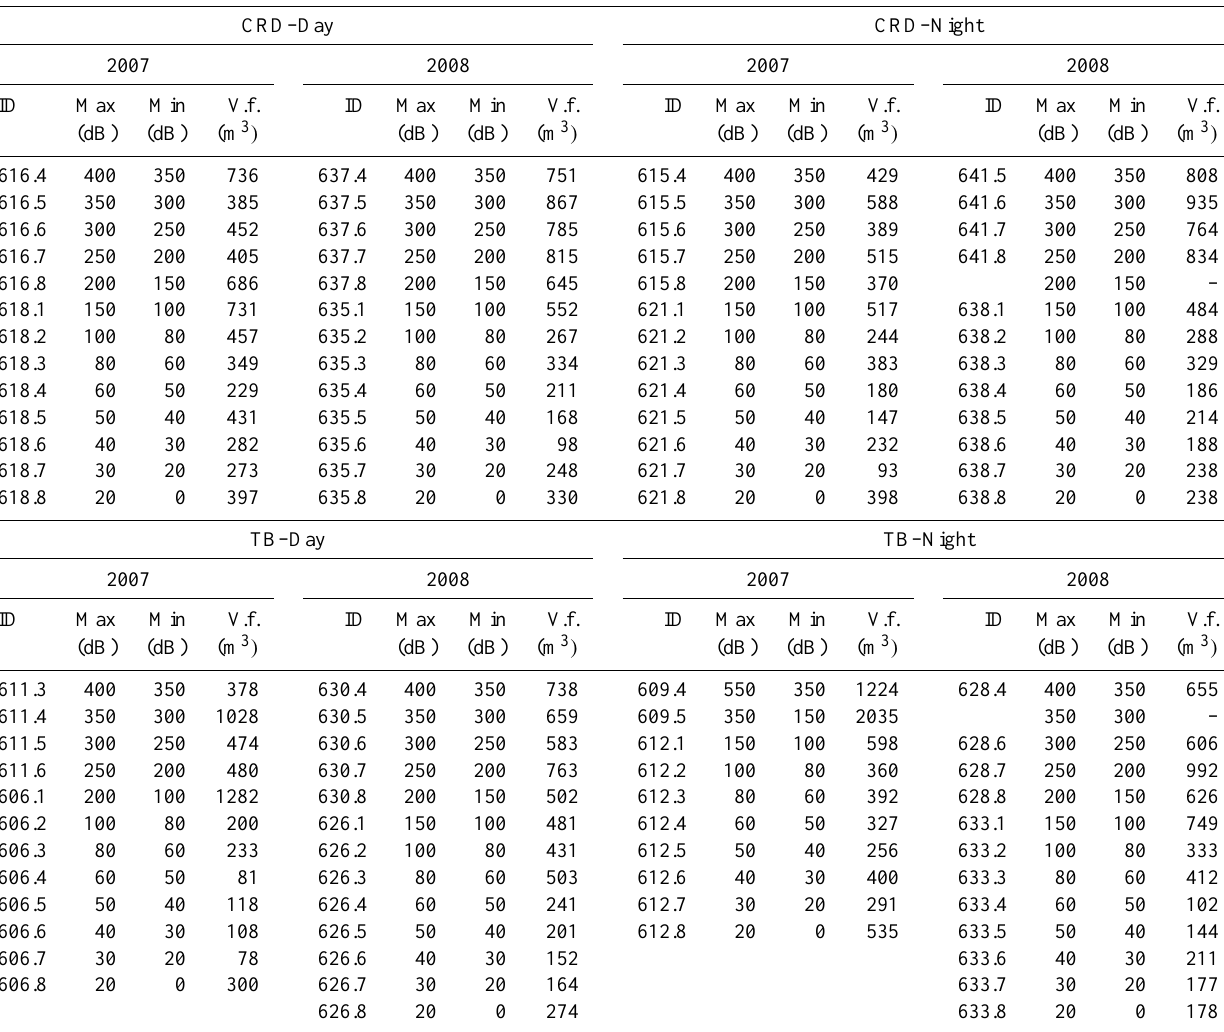
Table 2. MOCNESS net parameters and average hydrographic data for each day and night net tow (tow identification, ID) at the Costa Rica Dome (CRD) and Tehuantepec Bowl (TB) during 2007 and 2008. Minimum and maximum pressures are recorded in decibars (dB) and served as a proxy for depth (1dB ≈ 1m). Volume of water filtered through each net was measured in m 3 (V.f.). MOCNESS data has been made available by K.